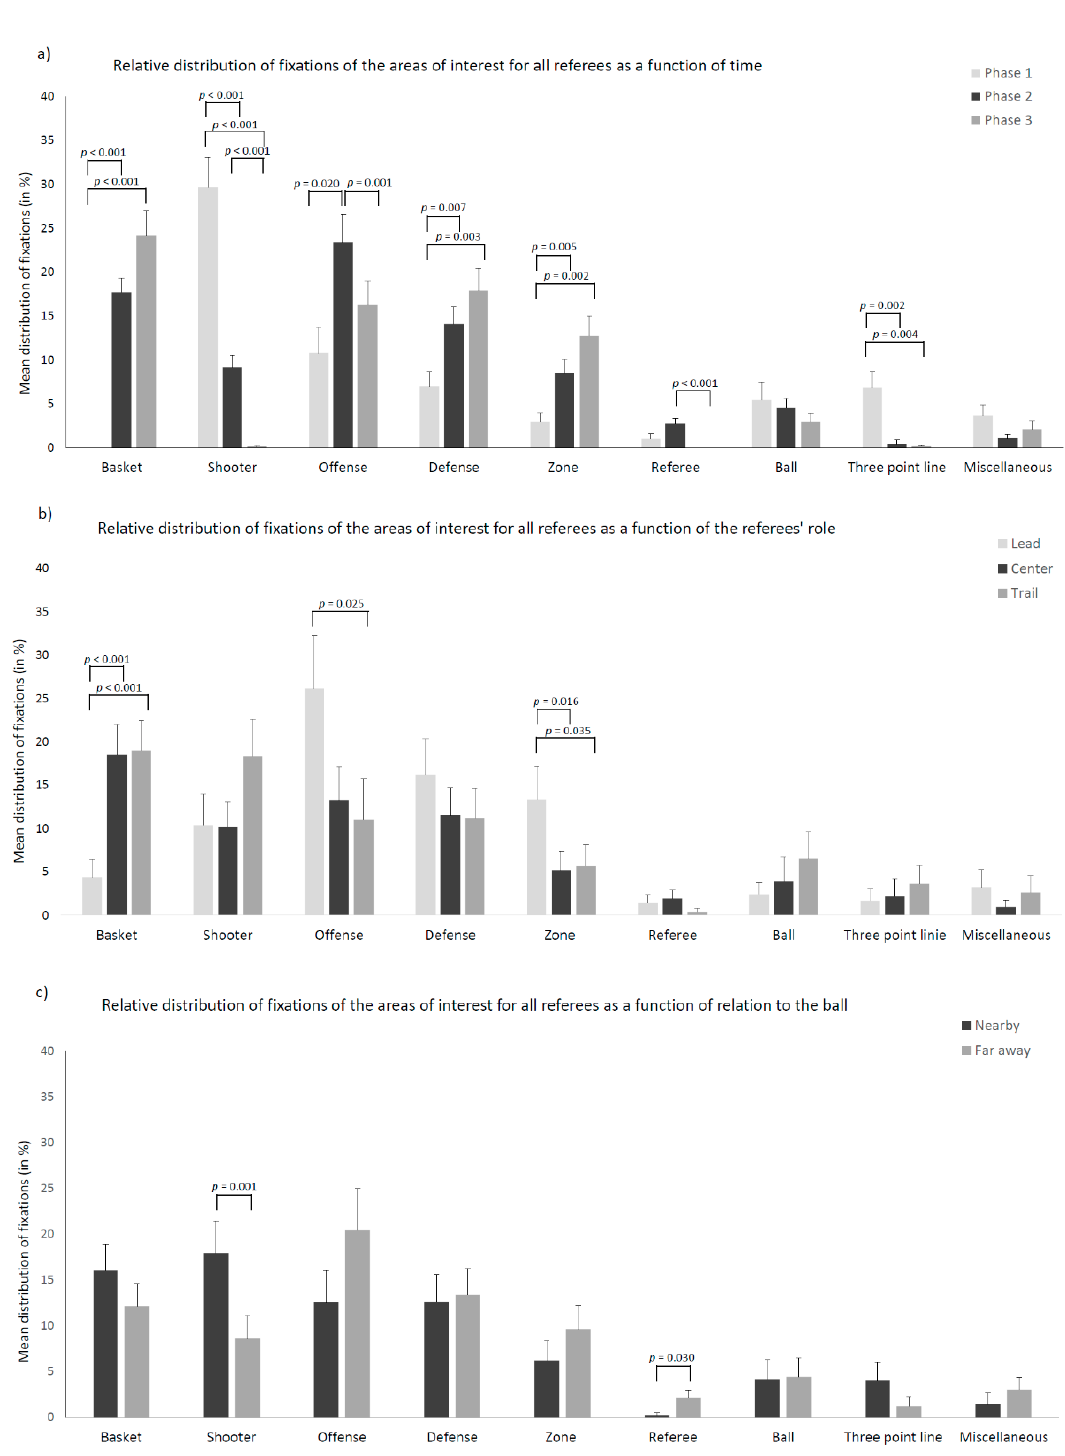
Figure 4. Mean distribution (and standard errors) of fixations of the areas of interest for all referees as a function of ( a ) time, ( b ) the role, and ( c ) relation to the ball. A 3 (Role: Lead, Center, Trail) × 2 (Relation to the ball: nearby, far away) × 3 (Time: phase 1, phase 2, phase 3) was conducted with fixation times towards the different areas of interest as dependent variables. Multivariate analyses showed a main effect of role , V = 0.344; F (18, 286) = 3.30, p < 0.001, Cohen’s f = 0.368, relation to the ball, V = 0.161; F (9, 142) = 3.03, p = 0.002, Cohen’s f = 0.347, and time, V = 0.764; F (18, 133) = 23.86, p < 0.001, Cohen’s f = 1.645. Interactions be- tween time and role, V = 0.522; F (36, 268) = 2.63, p < 0.001, Cohen’s f = 0.439, and between time and relation to the ball, V = 0.225; F (18, 133) = 2.15, p = 0.007, Cohen’s f = 0.369, showed significant effects, too. Interactions between relation to the ball and role, V = 0.081; F (18,